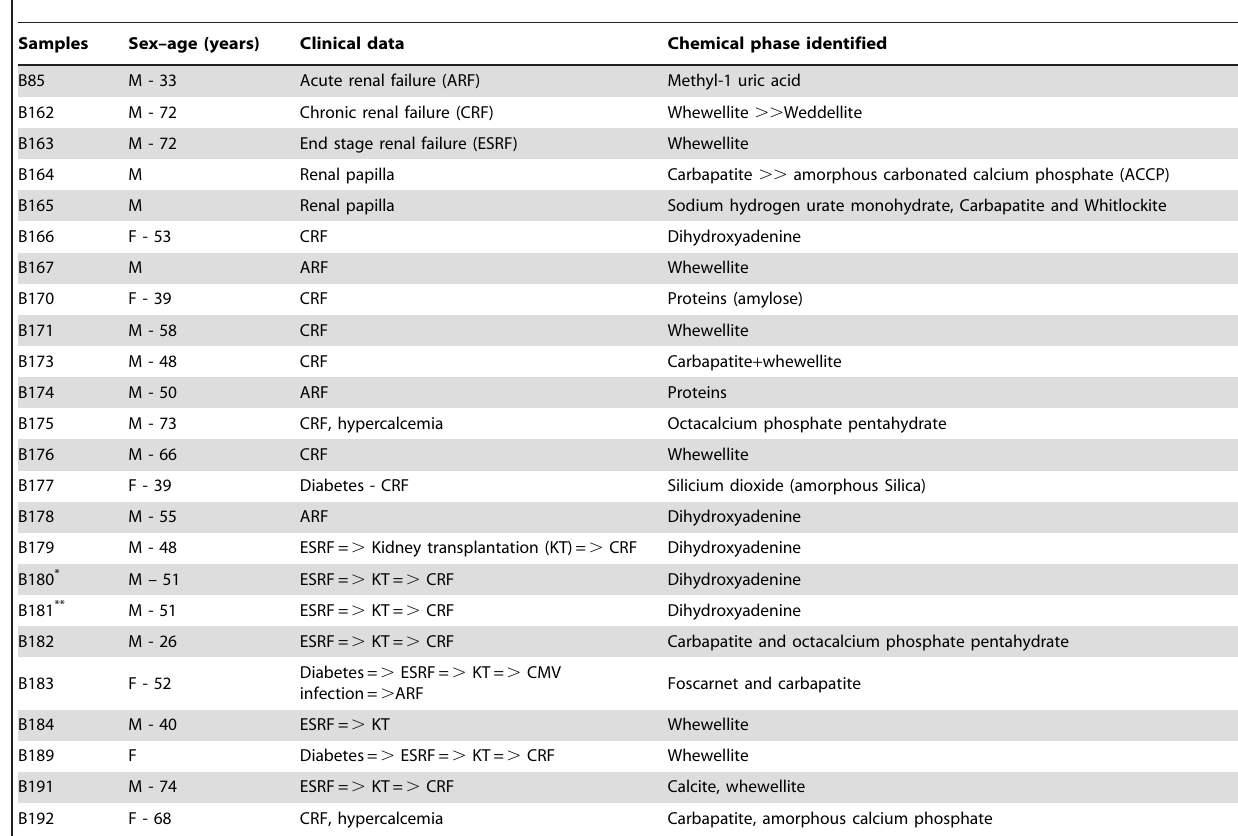
Table 1. Different chemical phases identified in this